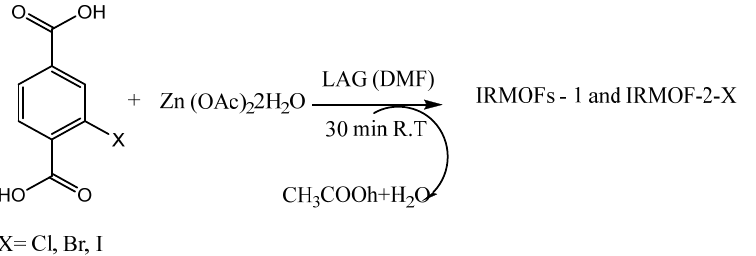
Figure 12. Mechanochemical synthesis of IRMOF-1 and IRMOF-2-X (X = Cl, Br, I).